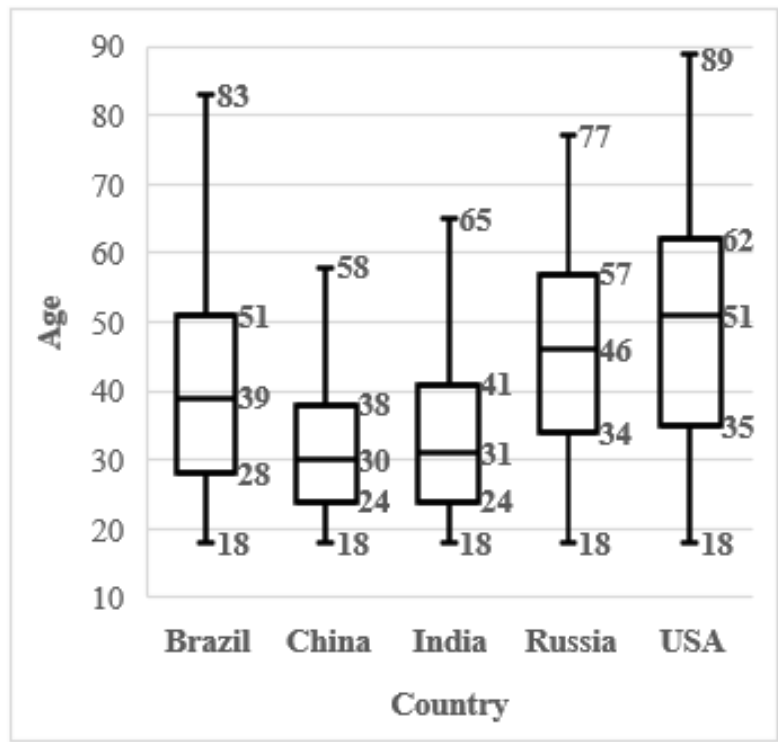
Figure 1. Sampled variables distribution. Ages within countries.